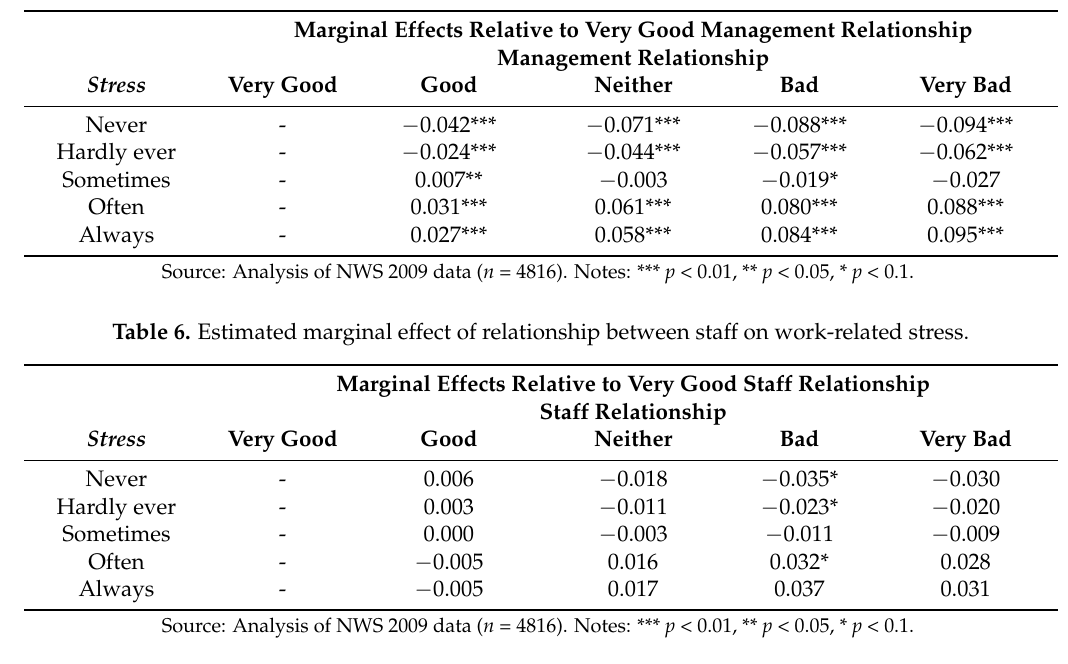
Table 5. Estimated marginal effect of relationship between management/staff on work-related stress.